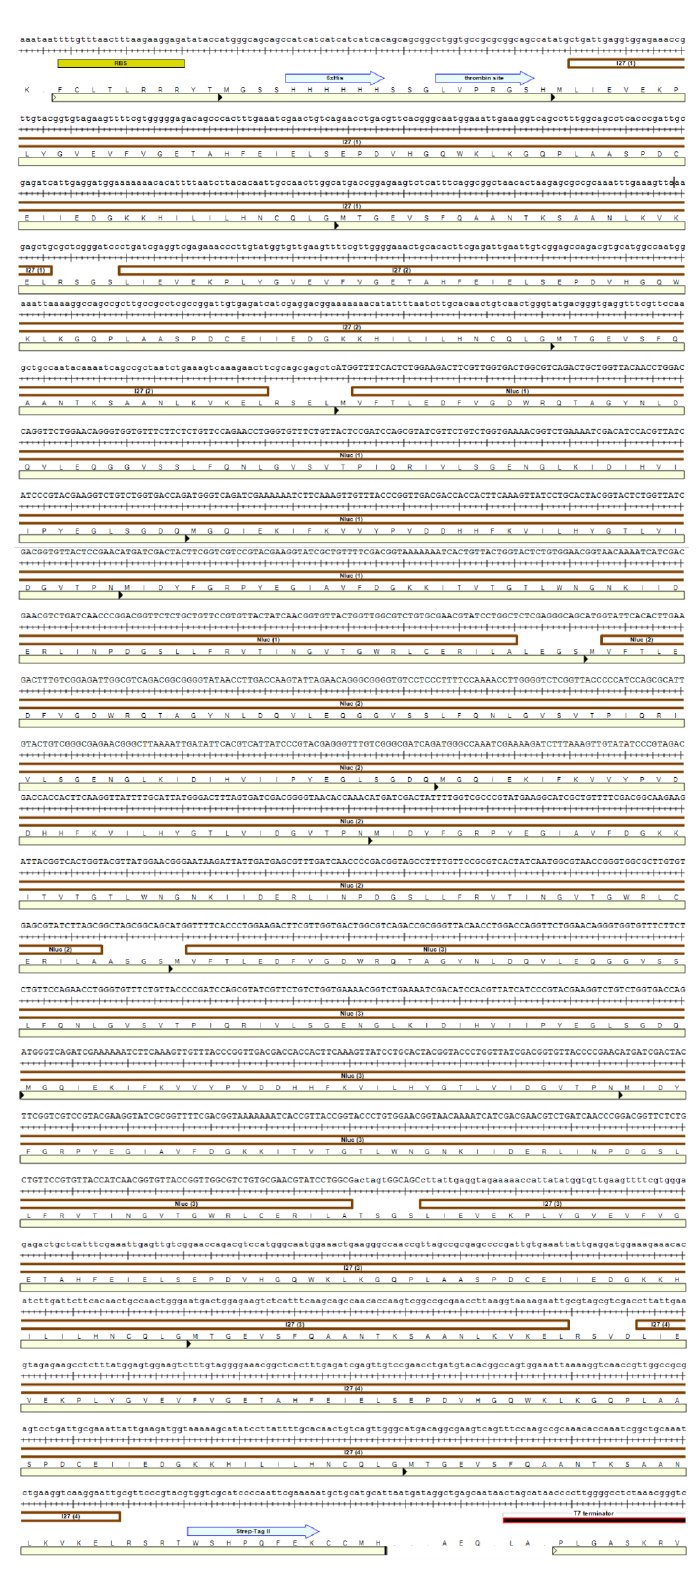
Figure 8. Nucleic acid (5 (cid:48) to 3 (cid:48) ) and amino acid (N to C-terminus) sequence of I91 2 -NanoLuc 3 -I91 2 construct. Different repeats are marked with a parenthesis with the number of repeat, such as I91 (1). HisTag (6xHis) and StrepTag (Strep-Tag II) are marked with a blue arrow. Proteins are indicated by a brown bar and a light yellow bar is used for the amino acid sequence. DNASTAR program was